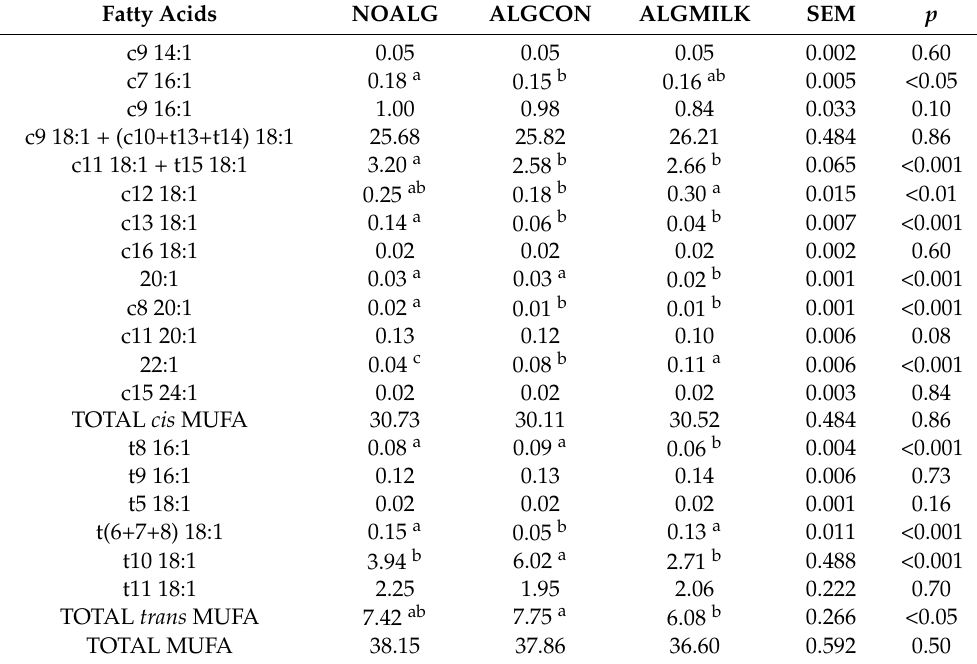
Table 3. Monounsaturated fatty acid (MUFA) profile (g/100 g of total fatty acid methyl esters) in intramuscular fat of feedlot lambs fed a conventional diet alone (NOALG) or feedlot lambs with competent reticular groove reflex fed the same diet supplemented with 2.5% of algae meal, either mixed in the concentrate (ALGCON) or in the milk replacer